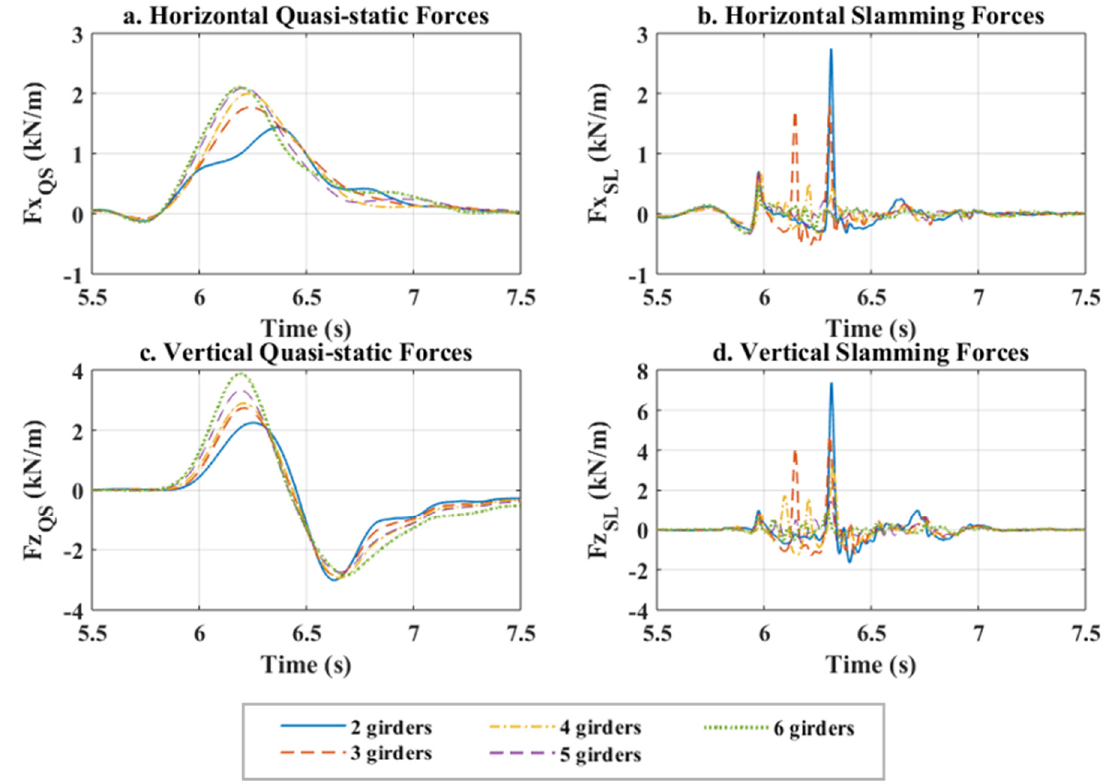
Figure 9. Time histories of quasi-static and slamming force components of decks with a different number of girders for SW3 ( H = 0.68 m).